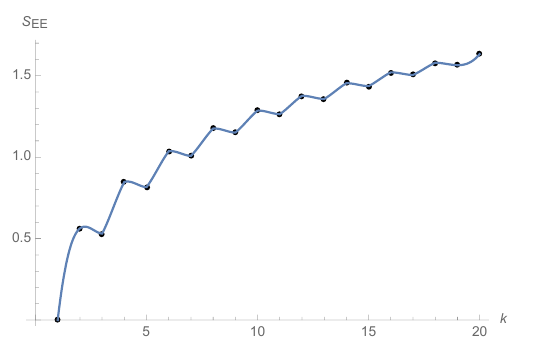
Figure 15 . The entanglement entropy for the Borromean rings as a function of k